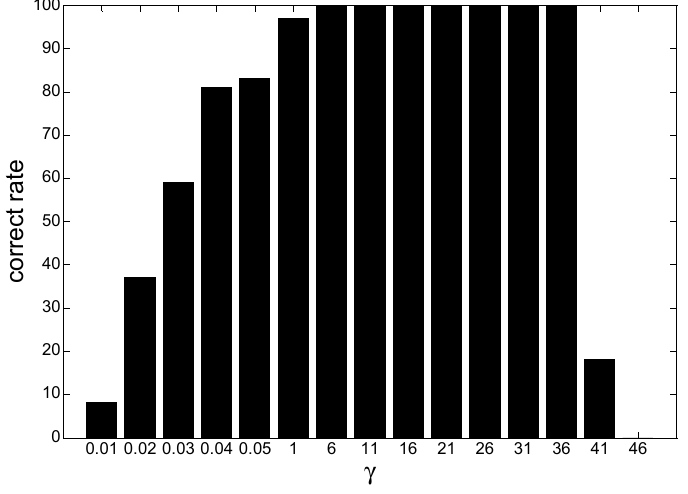
Figure 6. The rate of “correct” extractions versus varying threshold γ .